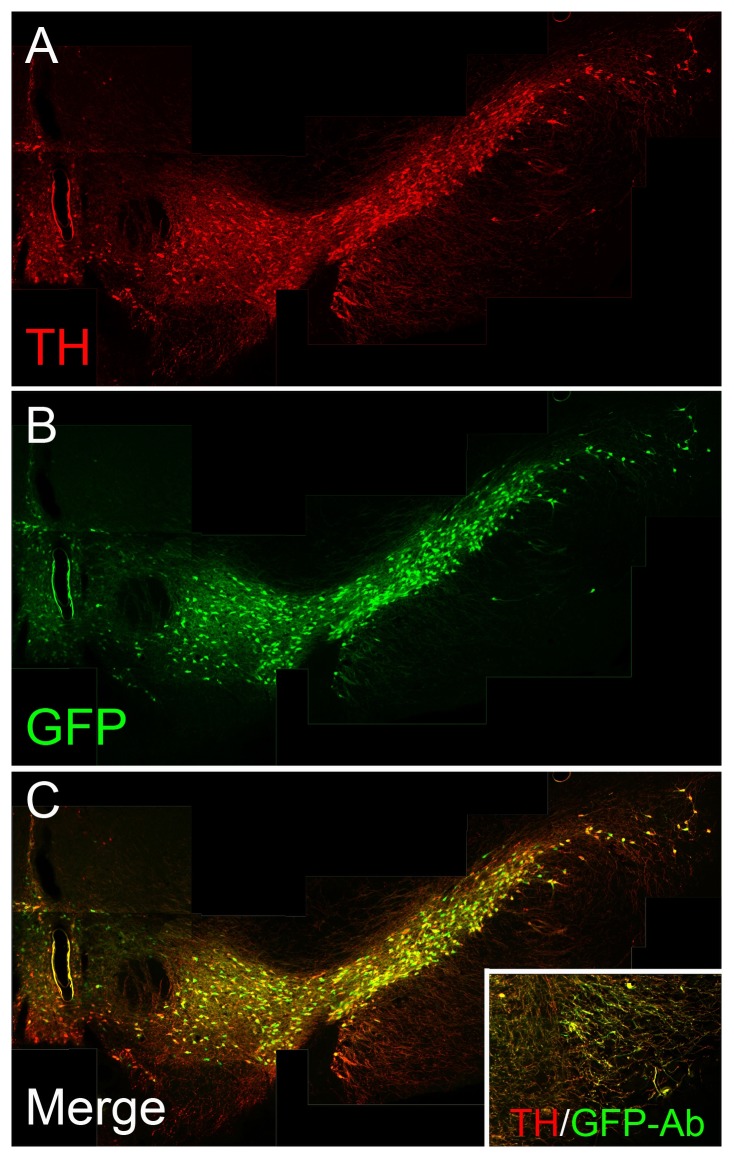
hTH-GFP expression correlates with TH expression in the adult midbrains of Line 12141.TH staining (A) co-labels with GFP (B) expression in midbrain areas, especially in the cell bodies (C) of the SNpc and VTA. The inset of Panel (C) shows that GFP antibody can detect GFP signals in the fine dendritic processes emanating from the cell bodies into the SN pars reticulata (SNpr), which are not as easily visualized by GFP fluorescence in Panel C.